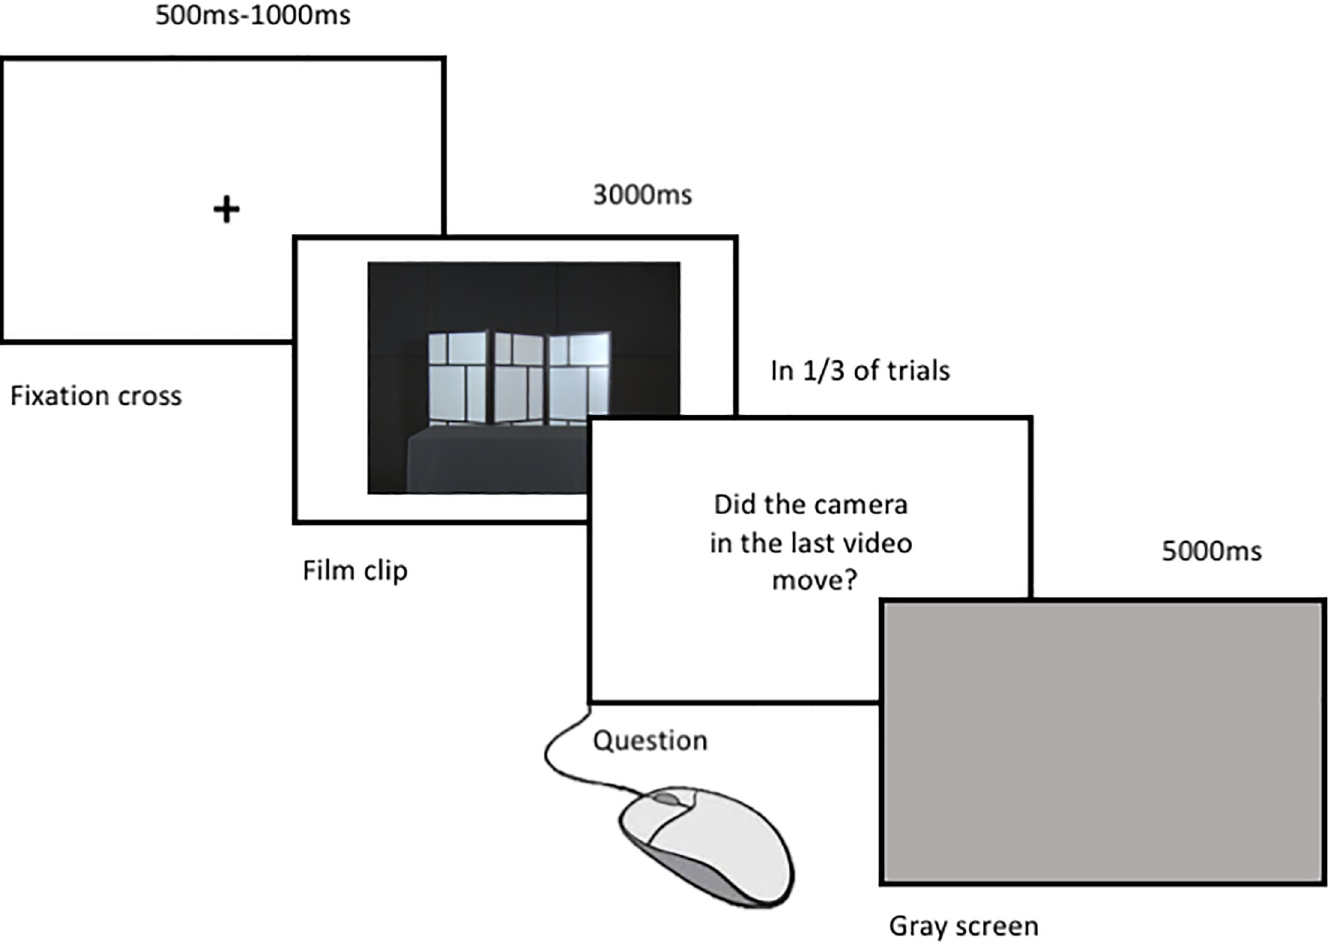
Fig 2. Experimental paradigm employed during EEG